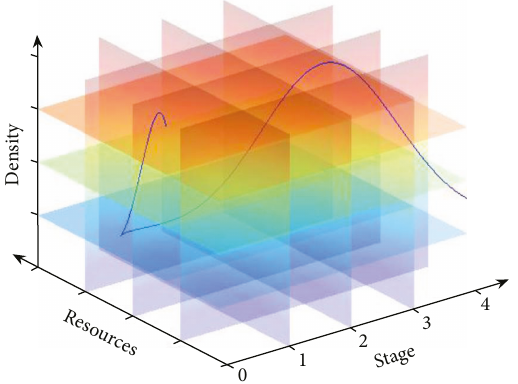
Figure 1: Changes in group personnel densities and resources in di ff erent periods of the life